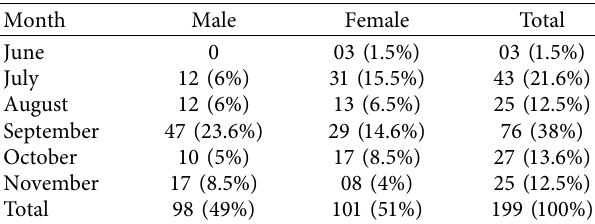
Table 2: Gender-wise distribution of the study population who were COVID-19